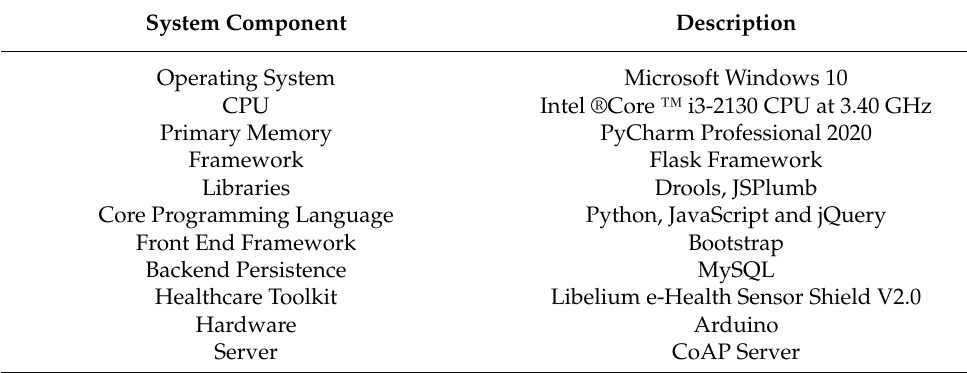
Table 5. Development Environment of Proposed Smart